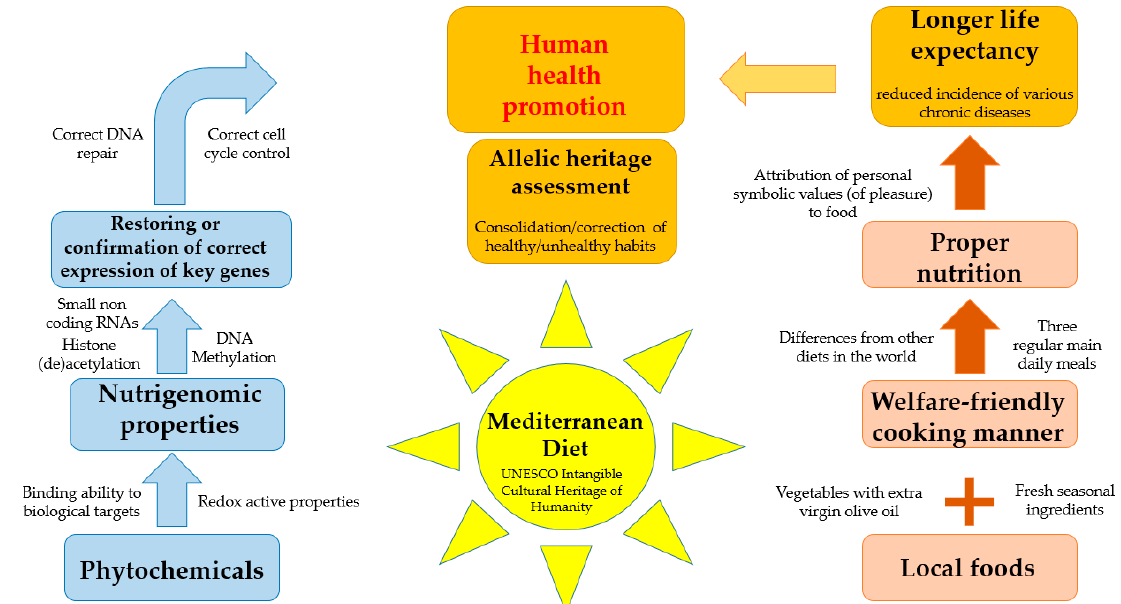
Figure 2. Patchwork expressing the “whole” concept of MD healthy properties. The left block of the diagram shows peculiar biological flowcharts; the right one displays selected non-biological points. The MD, interconnecting with both the blocks and taking advantage of an allelic assessment, represents a network promoting human health.